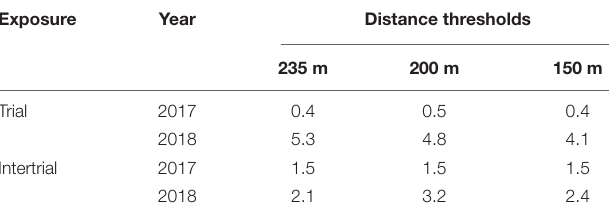
TABLE 3 | Distance in kilometers at which the probability of being far from the coast was half of that seen during normal behavior for given exposures at three different thresholds of distance to